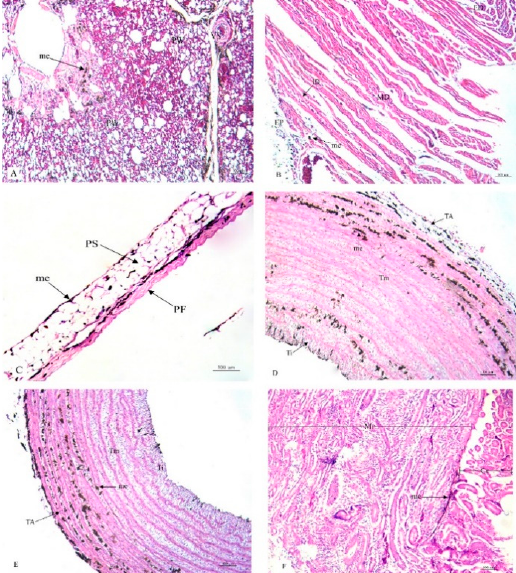
Figure 2. Histological location of melanin pigment in each organ; lung ( A ), heart ( B ), pericardium ( C ), aorta ( D ), brachial vein ( E ), kidney ( F ). Abbreviations: PW, parabronchial wall; VS, blood vessel; EP, epicardium; MD, myocardium; ED, endocardium; PF, fibrous pericardium; PS, serous pericardium; TA, tunica adventitia; Tm, tunica media; Ti, tunica interna; Cr, cortex; Mr, medulla; me, melanin pigment. Low magnification, H&E